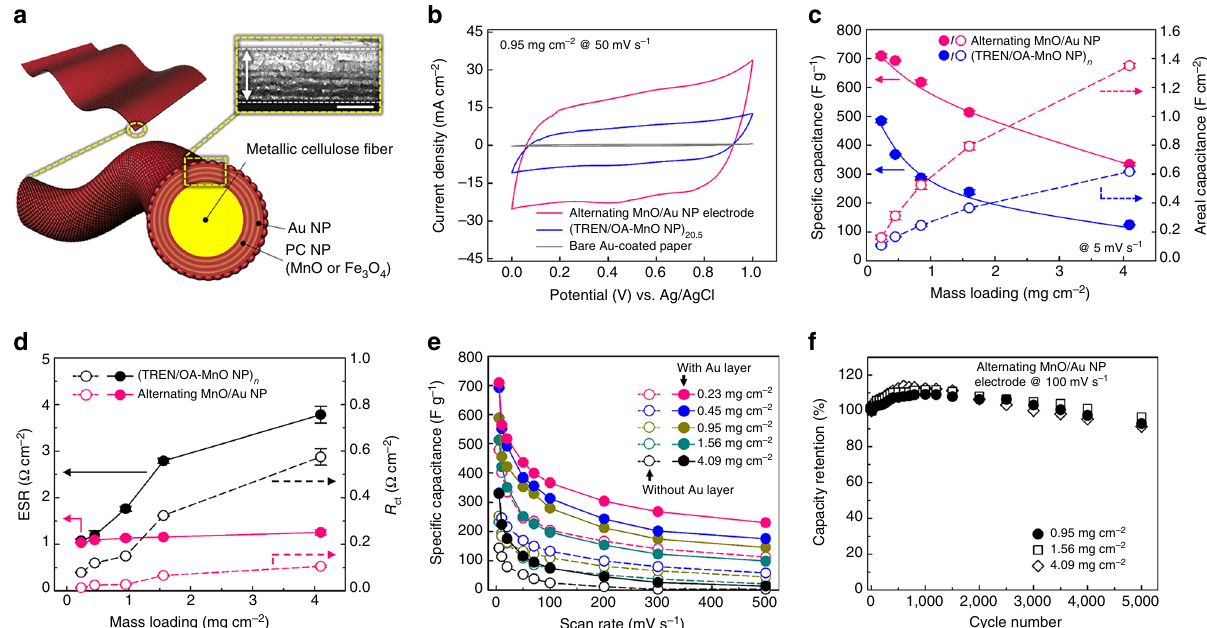
Fig. 4 Electrochemical properties of the alternating MnO/Au NP electrode. a Schematics of the alternating PC/Au NP electrodes. The FE-SEM micrograph shows the cross-sectional view of the alternating MnO/Au NP electrode. The size of the scale bar is 200 nm. b Comparison of the current responses of the alternating MnO/Au NP and the (TREN/OA-MnO NP) 20.5 -coated MP electrodes at a scan rate of 50 mV s − 1 . c Speci fi c and areal capacitances of alternating MnO/Au NP electrodes as a function of the mass loading of MnO NPs at a scan rate of 5 mV s − 1 . d Traces of the ESR and R ct values of the alternating MnO/Au NP and (TREN/OA-MnO NP) n electrodes as a function of the mass loading, respectively. All values were collected from the Nyquist plot of each electrode in Supplementary Figs. 14 and 20. e Speci fi c capacitances of the alternating MnO/Au NP (with Au layer) and the (TREN/OA-MnO NP) n (without Au layer)-coated MP electrodes with different mass densities as a function of the scan rate, respectively. f Cycling retention of alternating MnO/Au NP electrodes with mass densities of 0.95, 1.56 and 4.09 mg cm − 2 ,